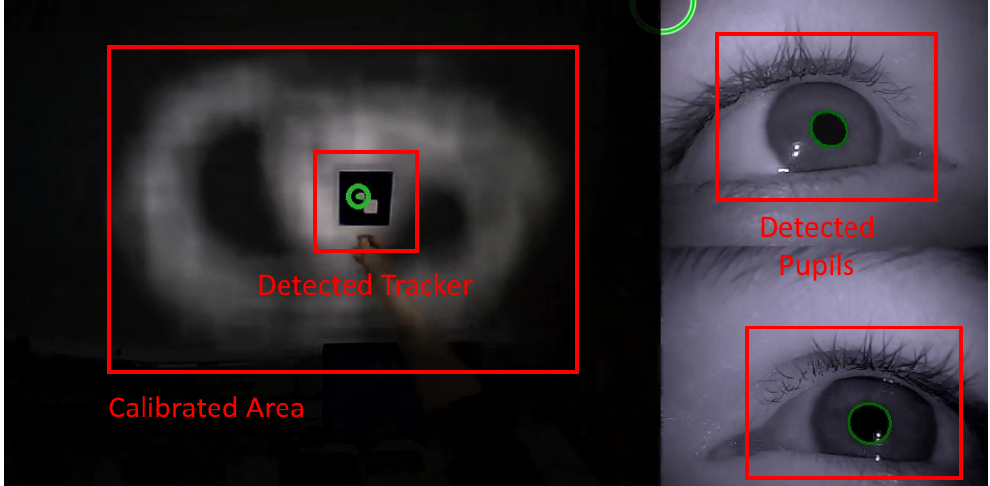
Figure 12. Screenshot of eye tracking calibration. Green labels are displayed by the eye tracking software to the therapist, rectangular red labels are inserted to mark concepts described in the